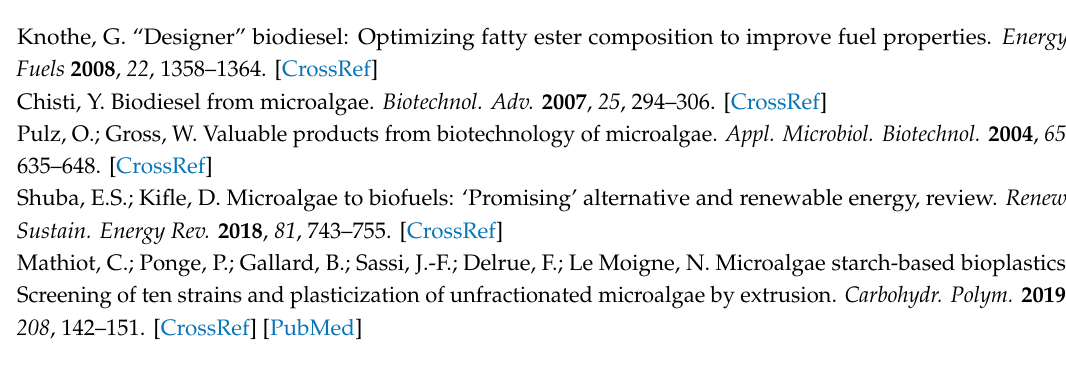
Figure S1: Growth curves of the selected algal